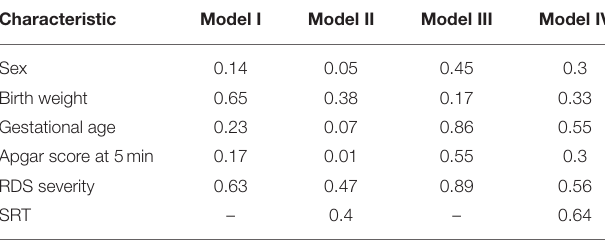
TABLE 2 | Relative importance score of variables in multivariate logistic regression.